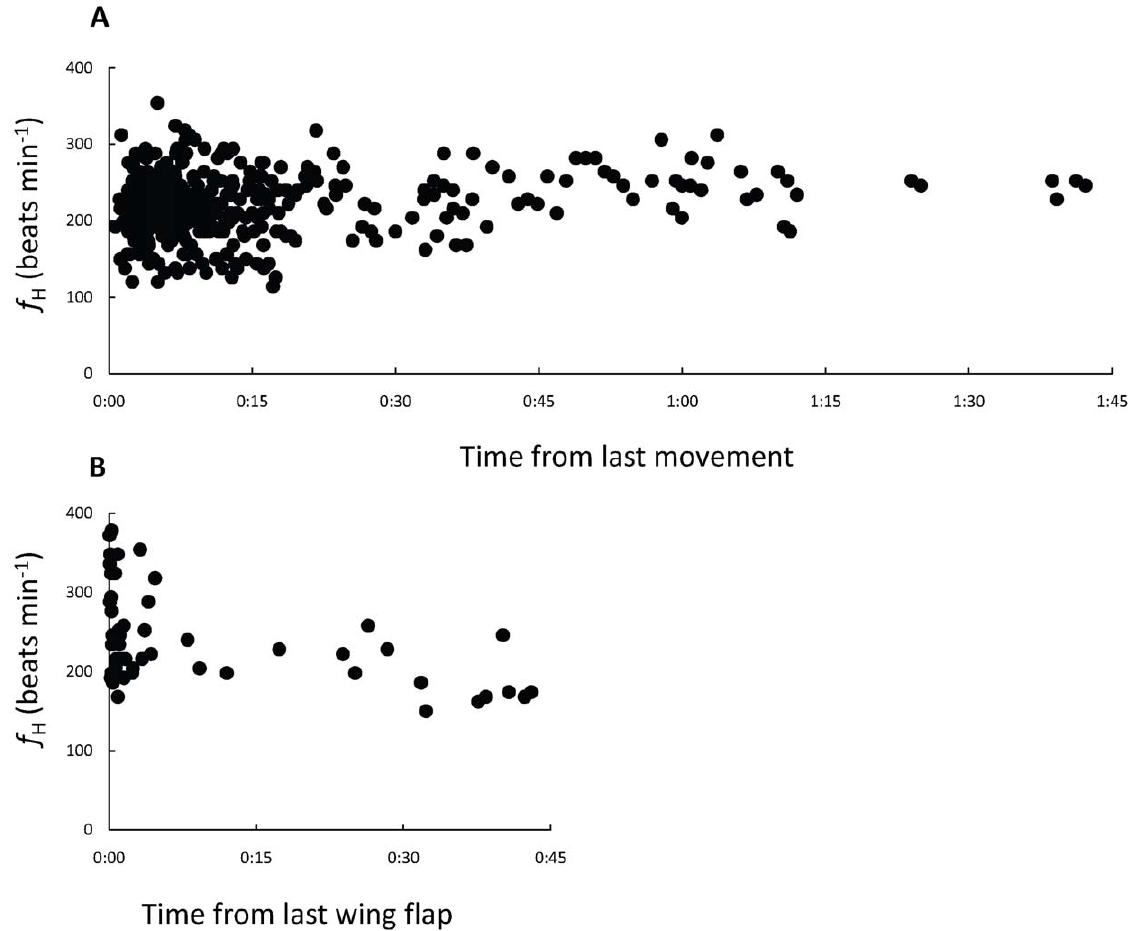
Figure 3. Heart beat frequency ( f H ) of European bee-eaters in relation to time during activity at rest and during soaring-gliding. (A) f H in relation to time from last movement during stopover. (B) f H in relation to time from last wing beat during soaring and gliding.